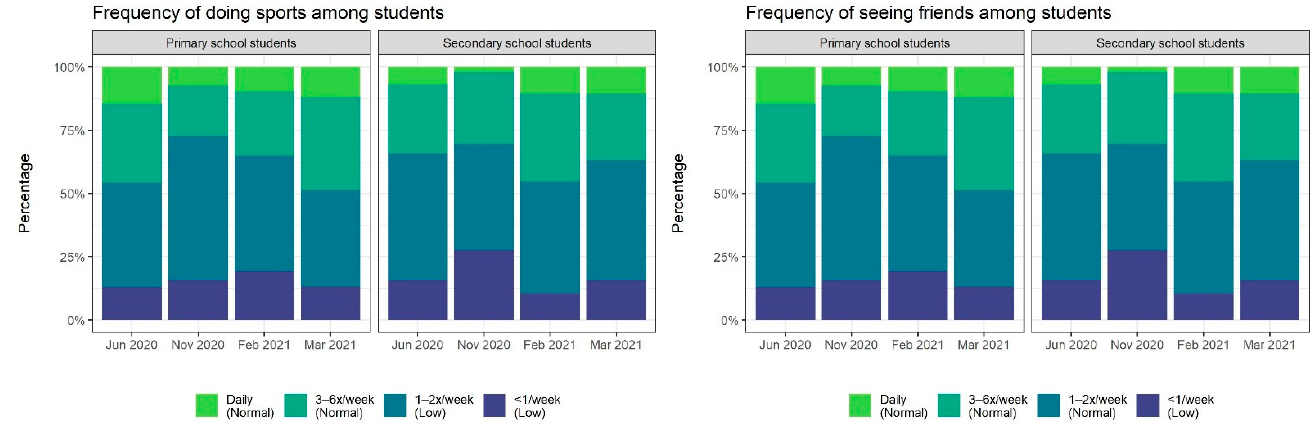
Figure 3. Physical and social activities among Berlin schoolchildren; June 2020 to March 2021.